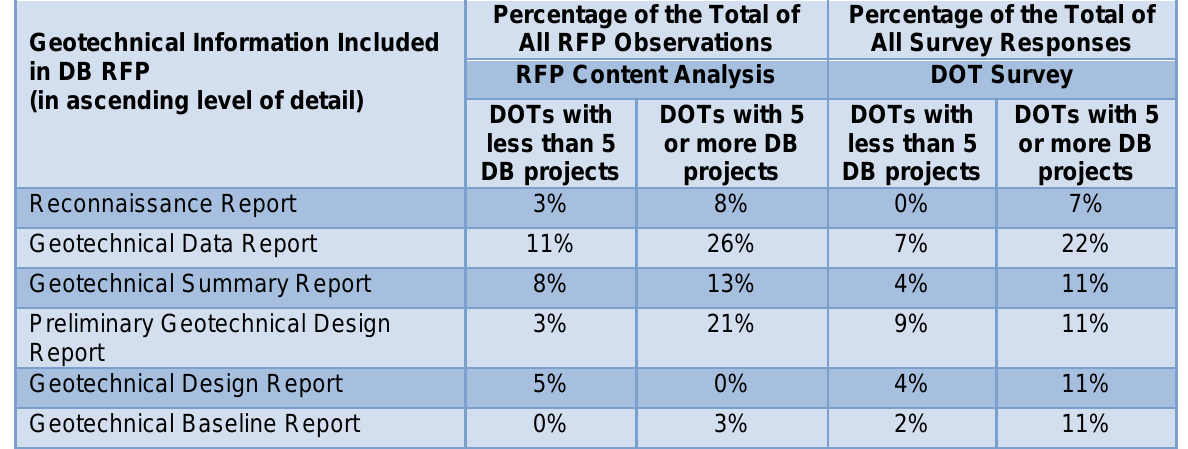
Managing Pre-award Geotechnical